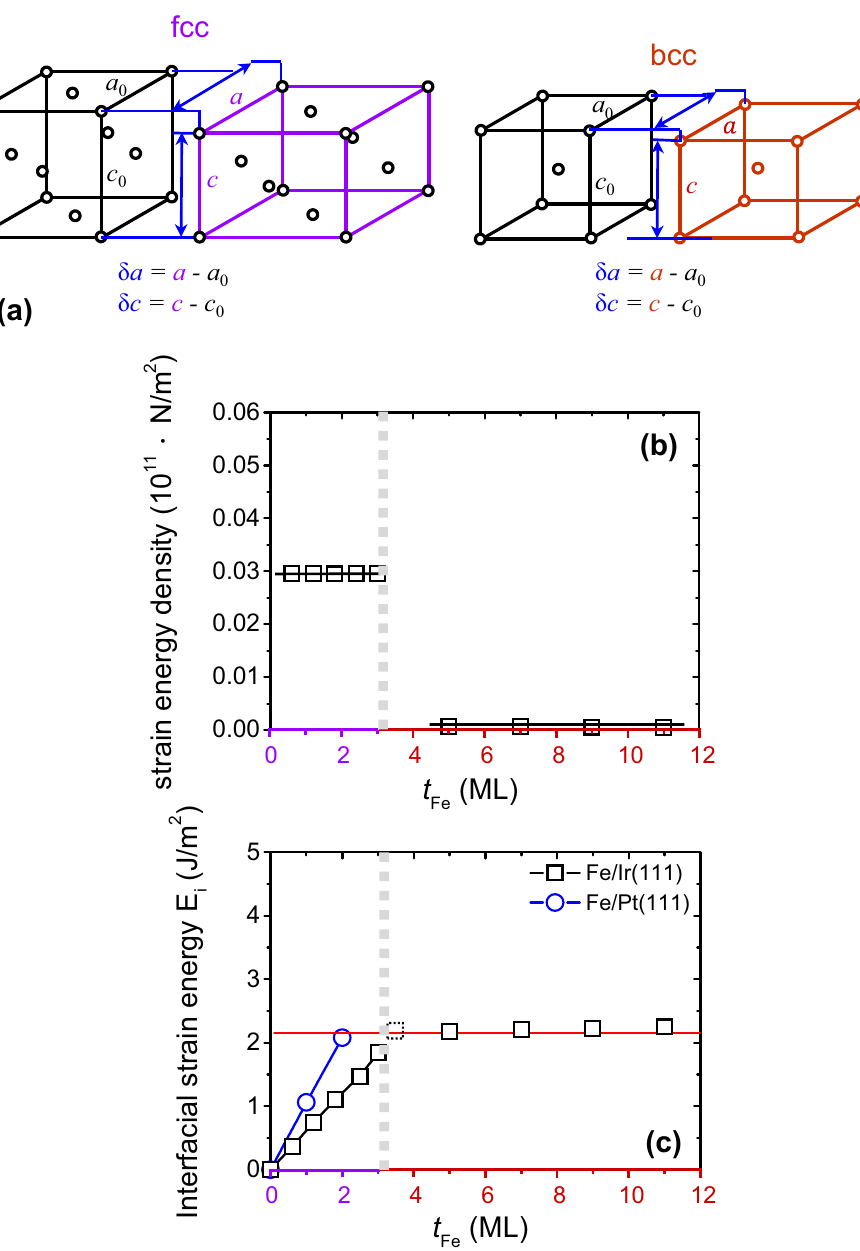
Figure 5. ( a ) Schematics of the original Fe bulk unit cells (black) and the distorted fcc (purple) and bcc (red) unit cells, where a 0 , c 0 and a , c are defined as the lattice parameters for the original and distorted fcc and bcc unit cells, respectively. ( b ) Strain energy density and ( c ) interfacial strain energy versus Fe thickness for Fe/Ir(111) (black squares) and Fe/Pt(111) (blue circles).